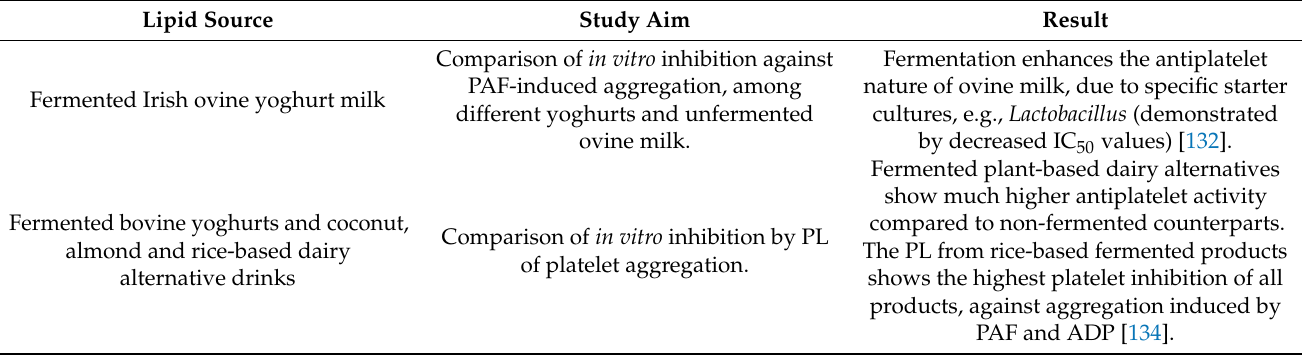
Table 2. Comparison of in vitro studies investigating dairy and marine lipids possessing antithrom- botic activity against PAF and other platelet